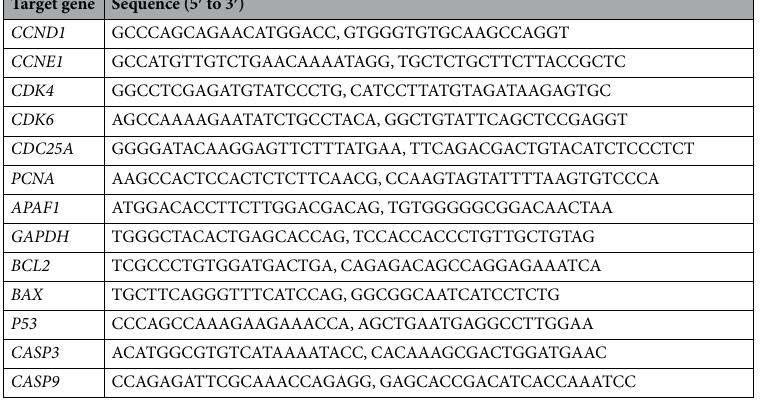
Table 2. Primers used for